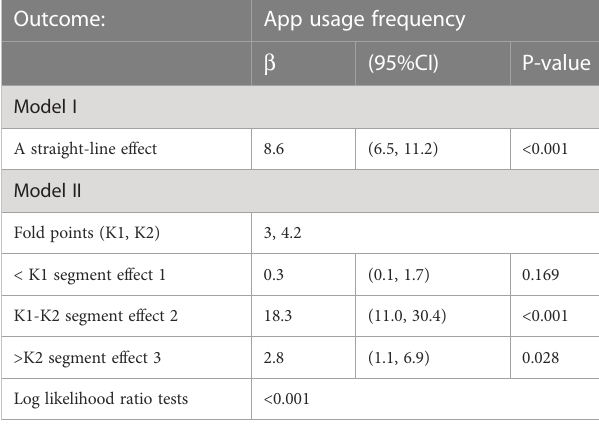
TABLE 4 Independent correlation between online information exchange and app usage frequency analysis by multiple segmented linear regression.